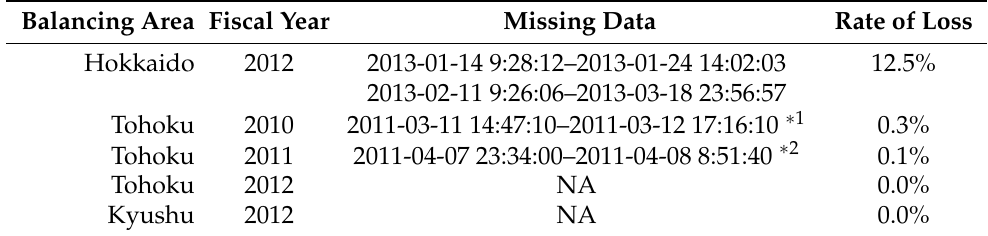
Table A1. Missing data of longer than 3